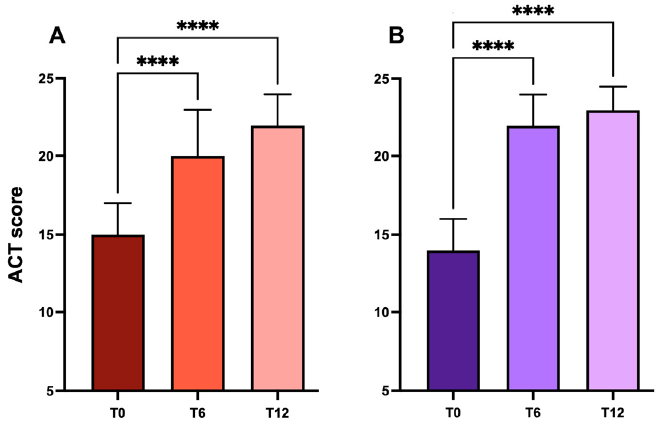
Figure 4. Effects of mepolizumab ( panel A ) and benralizumab ( panel B ) on ACT score over time (****: p < 0.0001).